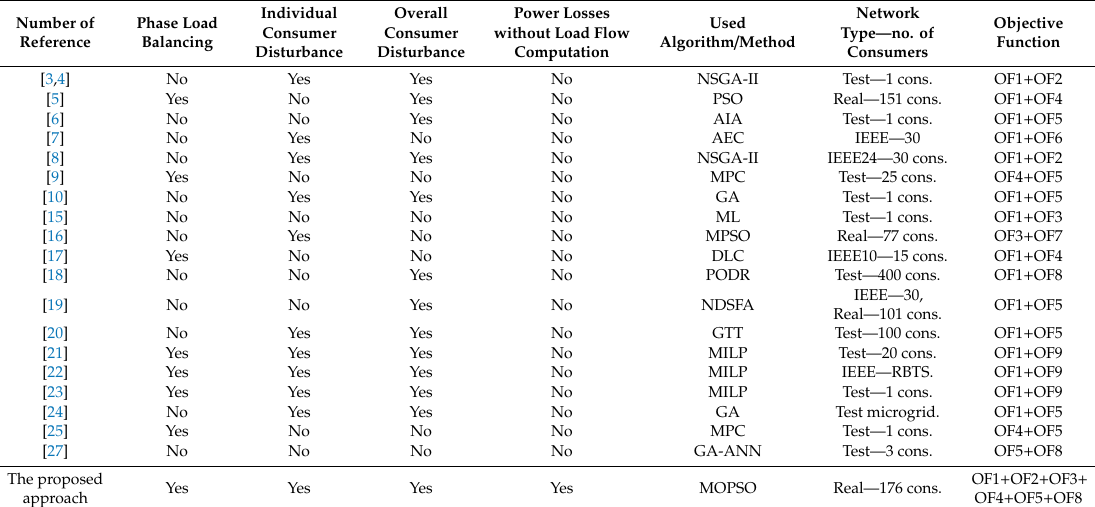
Network Used Type—no. of Algorithm / Method Consumers NSGA-II Test—1 cons. OF1 + OF2 Test—1 cons. IEEE—30 IEEE24—30 cons. Test—25 cons. OF4 + OF5 IEEE10—15 cons. OF1 + OF4 IEEE—30, + OF5 Real—101 cons. OF1 Test—100 cons. OF1 + OF5 IEEE—RBTS. OF1 + OF9